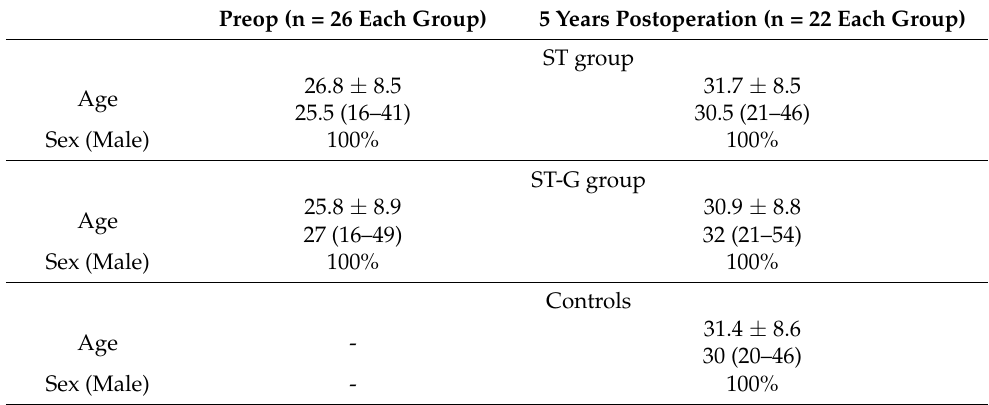
Table 1. Demographic data of the patients and controls. Preop—Preoperatively; ST—semitendinosus. ST-G—semitendinosus and gracilis. Data are means ± SD and median (25–75%